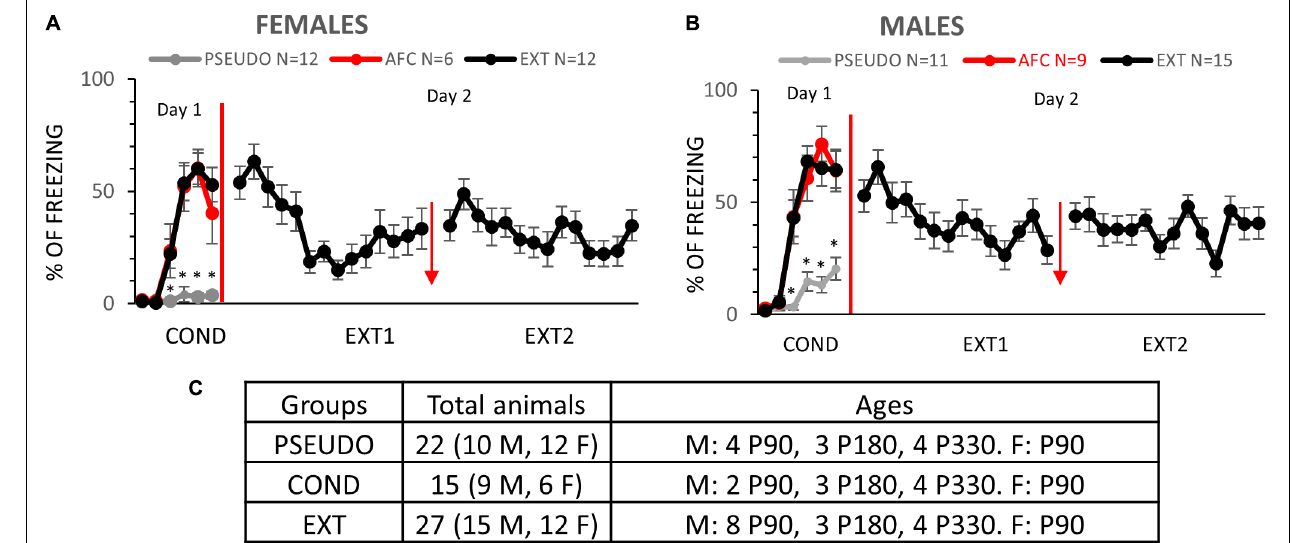
FIGURE 5 | Females and males learn AFC and fear extinction. (A,B) Fear responses during training in the PSEUDO, AFC, and EXT female and male groups, respectively. Red arrow indicates 1 h break between extinction sessions. (C) Distribution of animals by age and sex in experiment 2. * Denotes trials in which the AFC and EXT groups show more freezing than the PSEUDO group ( p ≤